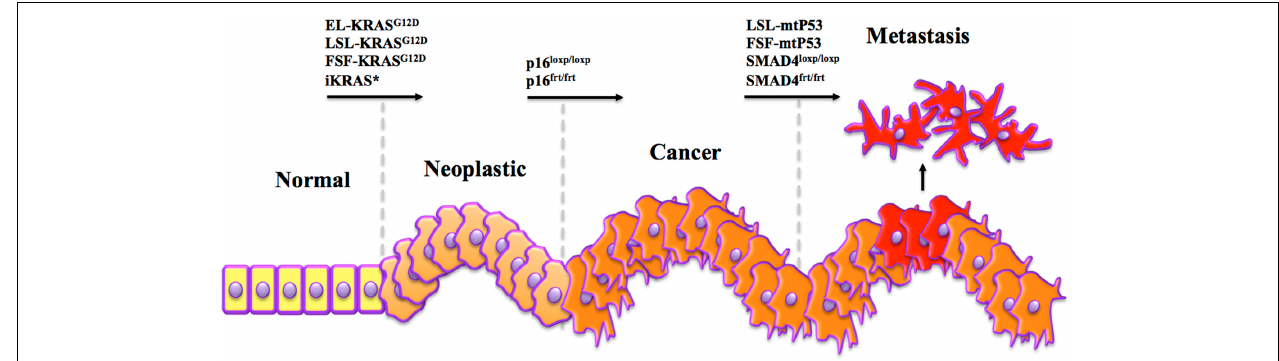
FIGURE 1 | Mimicking human tumorigenesis through temporal modeling of pancreatic cancer. A key difference between human pancreatic cancer and commonly used mouse models is in the timing of mutations. In human patients, Kras mutations are often considered an initiating event, occurring in adult cells, soon followed by mutations to p16 , and later p53 and/or SMAD4 . Yet in most models, Kras and altered tumor suppressor